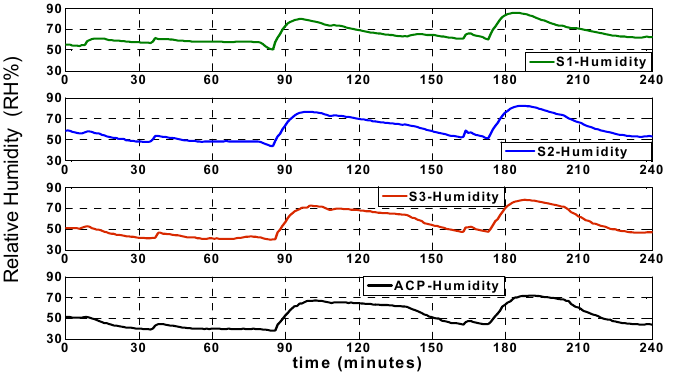
Figure 6. Actual humidity of reefer unit and sensor